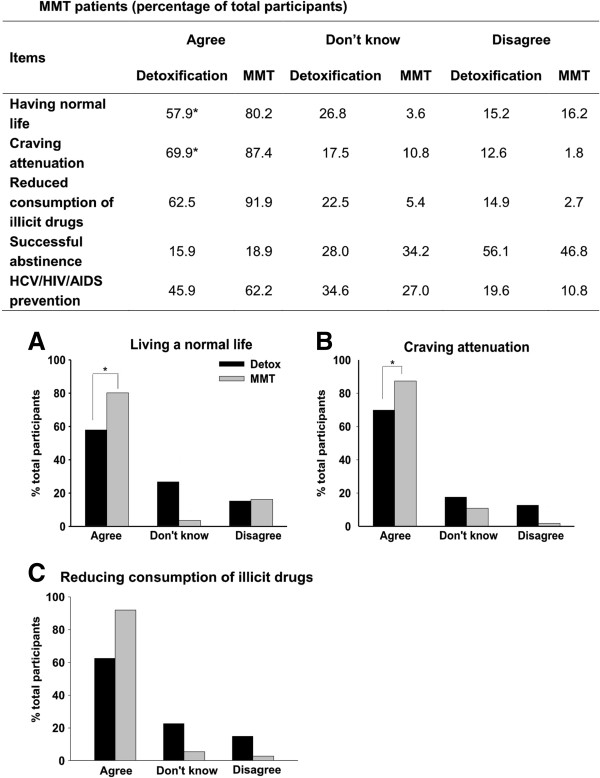
Positive attitudes toward MMT between participants at the Compulsory Detoxification Centre (black bars) and MMT patients (grey bars). Points represent the percentage of total participants agreed, didn’t know or disagreed each item of the questionnaire. (A): Methadone help me live a normal life; (B): Methadone help attenuate craving; (C): Methadone help reduce the consumption of illicit drugs. Asterisk (*) denotes a significant difference between Compulsory Detoxification and MMT patients, p < 0.05.